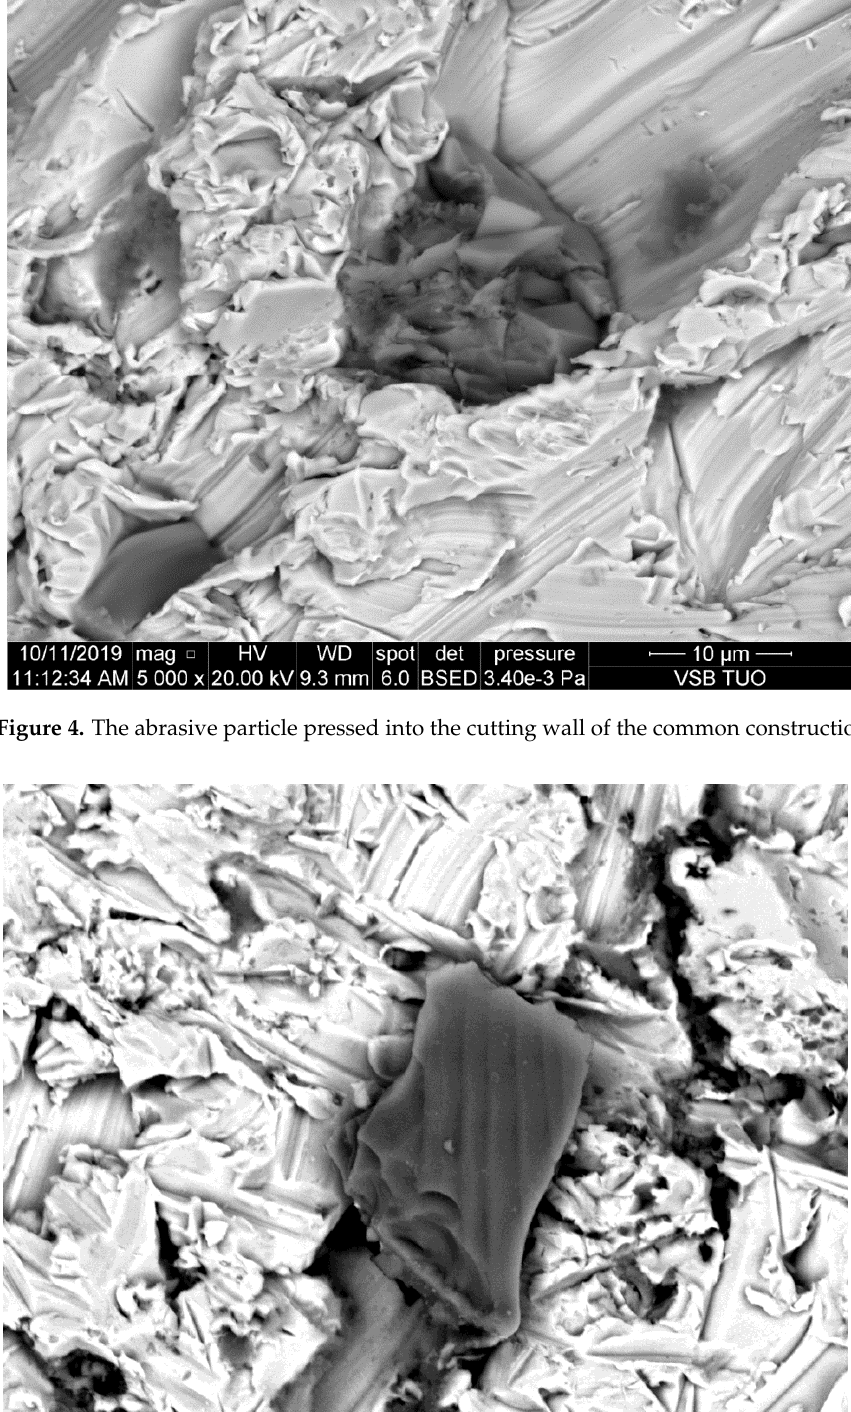
Figure 6. The abrasive particle embossed in the cutting wall of the high strength steel.